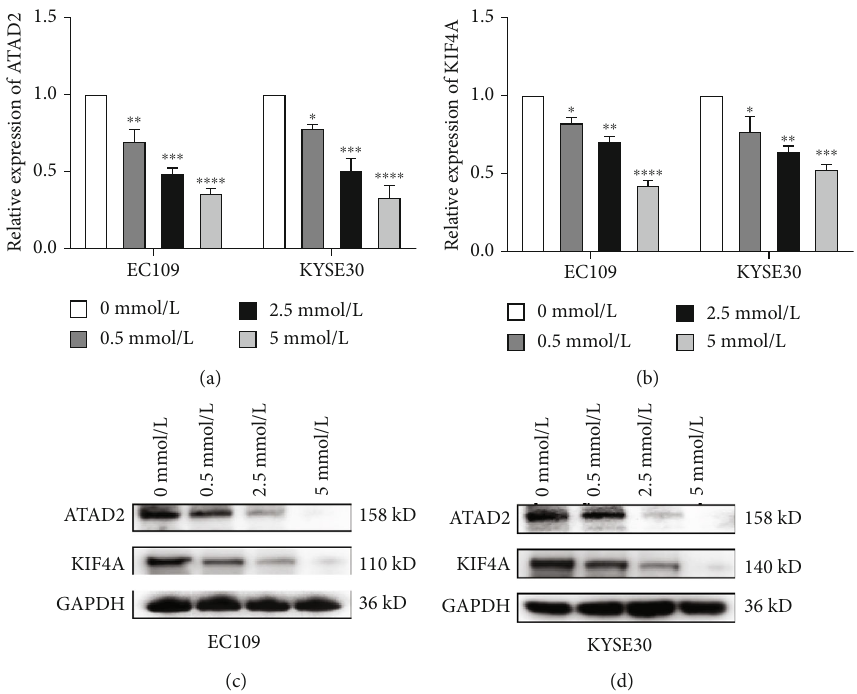
Figure 7: E ff ect of aspirin stimulation on mRNA expression levels ATAD2 and KIF4A. (a and b) Compared with aspirin 0 mmol/L group, the relative expression levels of ATAD2 and KIF4A mRNA in EC109 and KYSE30 cell lines decreased; (c and d) the protein expression levels of ATAD2 and KIF4A in EC109 and KYSE30 cell lines decreased. ∗ P < 0 : 05 , ∗∗ P < 0 : 01 , ∗∗∗ P < 0 : 001 , and ∗∗∗∗ P < 0 : 0001